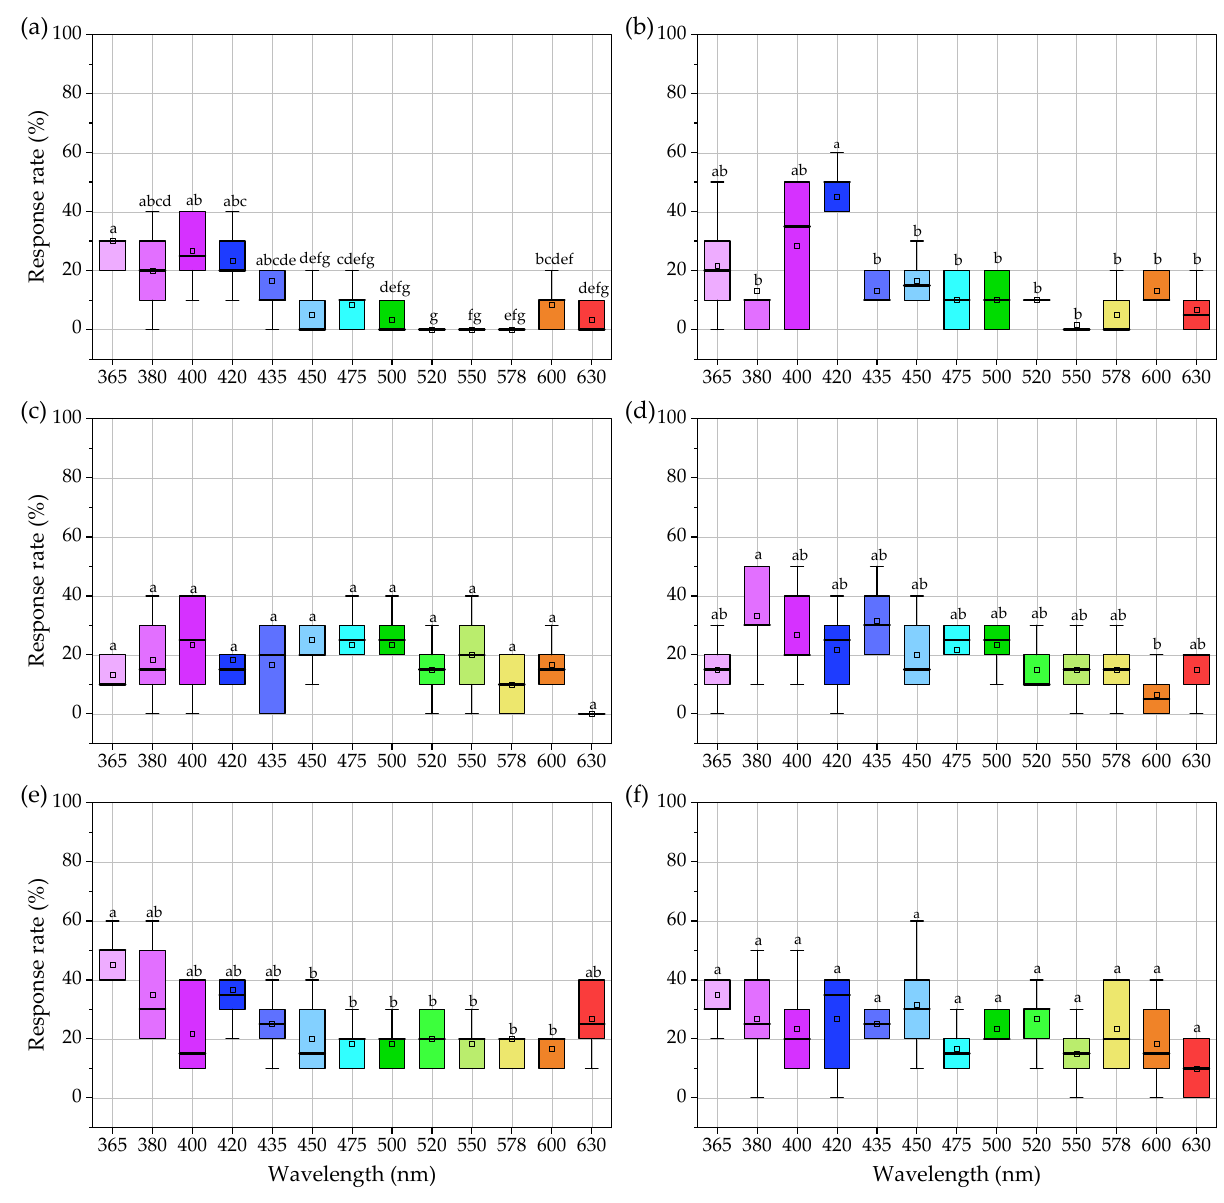
Figure 3. Phototactic reaction intensity of females and males of Exolontha castanea to different wavelengths. ( a ) G1 of females; ( b ) G1 of males; ( c ) G2 of females; ( d ) G2 of males; ( e ) G3 of females; ( f ) G3 of males. The upper and lower sides of the box plot are 75% and 25% quantiles, respectively. The line in the middle of the box represents the median of the data. The square are mean. Different lowercase letters indicate significant differences between wavelengths (Kruskal–Wallis test, p < 0.05). Unlike females, males had G1, G2, and G3 phototactic behavior to all monochromatic light. The phototactic response rate of G1 first increased and then decreased with the increase in wavelength, with the highest response rate of 45% at 420 nm (Figure 3b). This was significantly different from that of monochromatic light at other wavelengths ( χ 2 = 30.732; df = 12; p = 0.002). In each spectral treatment, the phototactic response rate of G2 (except for 600 nm) and G3 ranged from 10% to 35%, and there was no significant difference between different wavelength treatments ( p > 0.05) (Figure